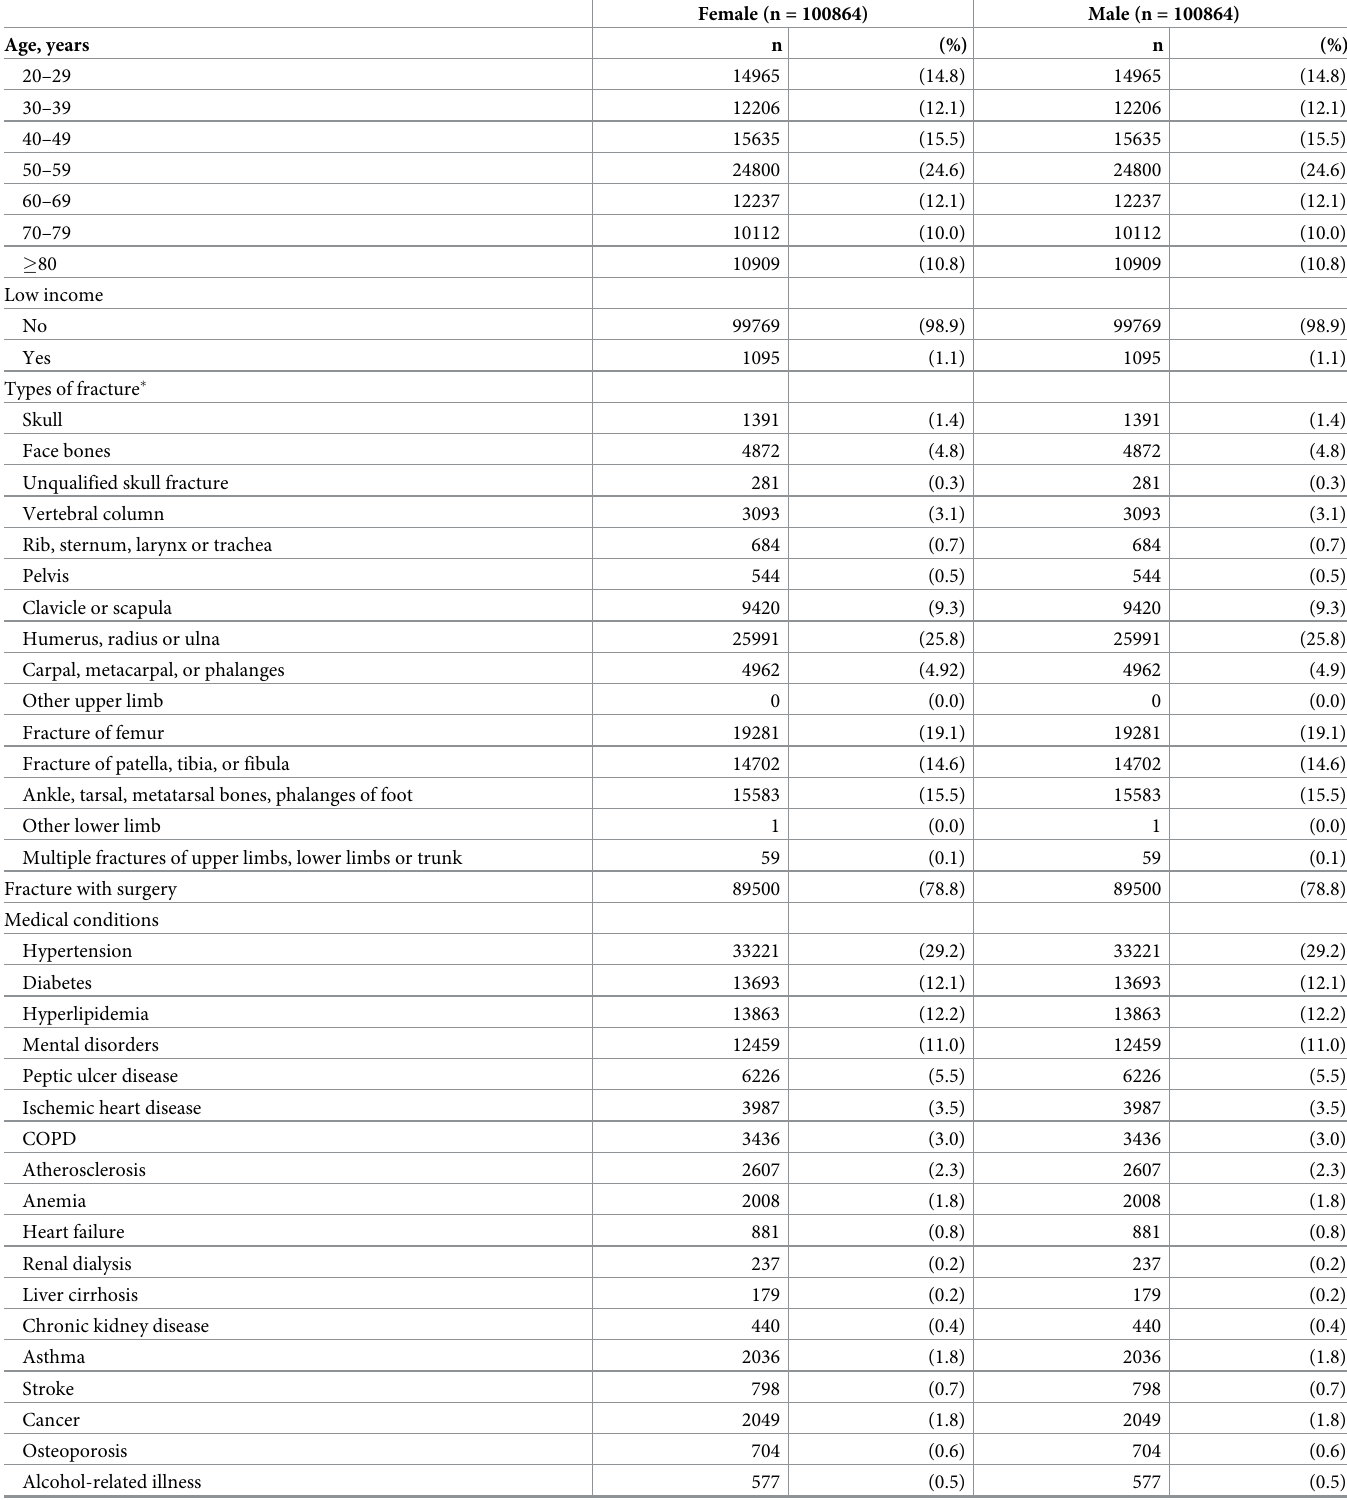
Table 2. Baseline characteristics in female and male fracture patients after